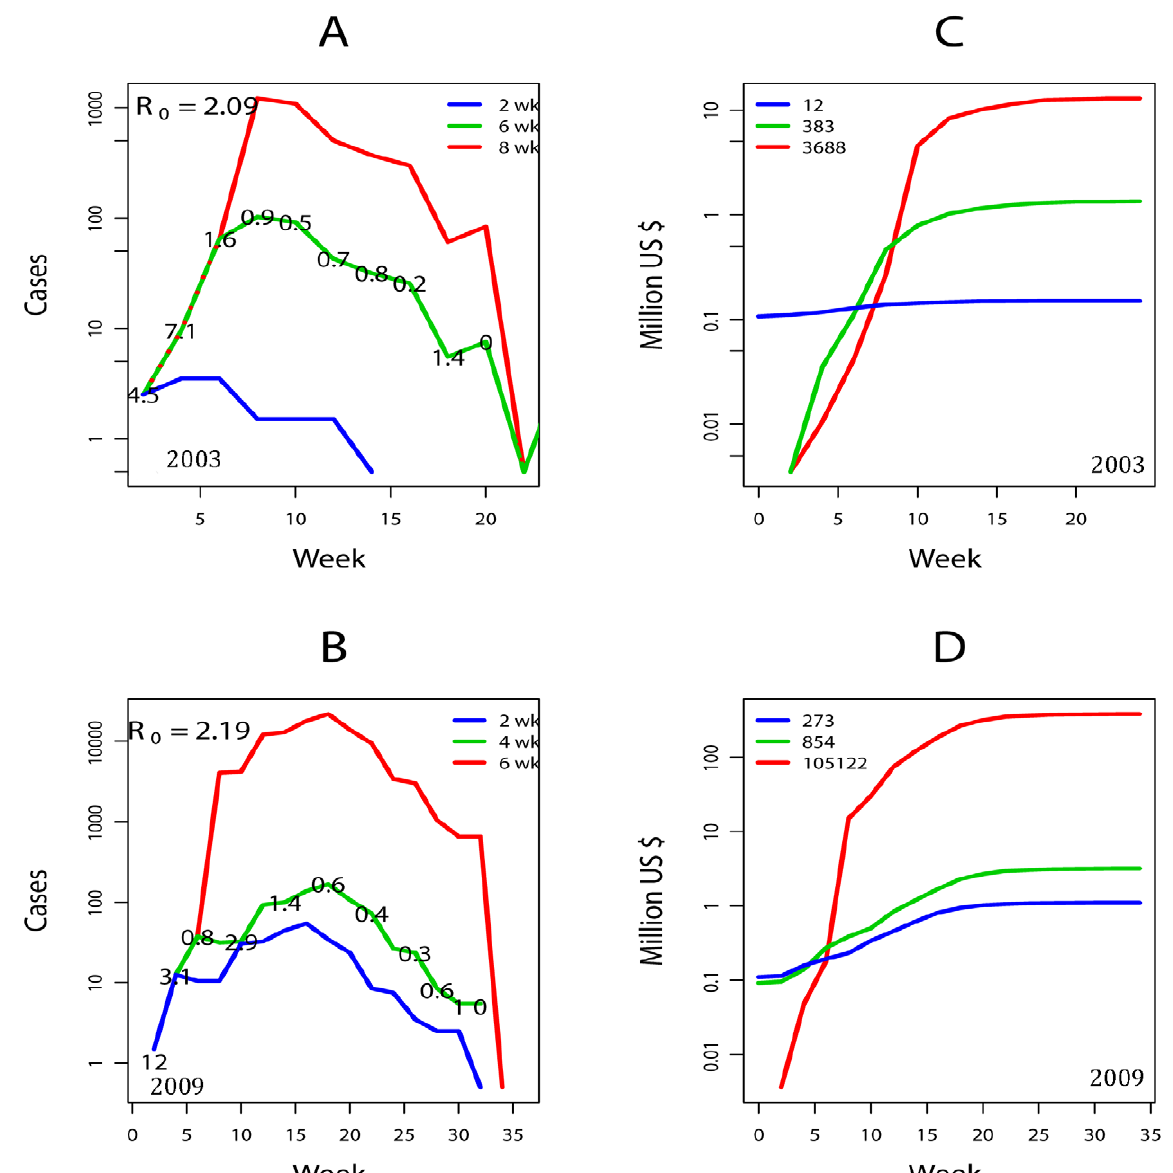
Figure 1. Impacts of hypothetical scenarios of delayed response of vector control to Dengue virus outbreaks. The basic reproduction number, R 0 (the average number of secondary cases after the introduction of an infection) for the 2003 and 2009 dengue fever outbreaks that affected the city of Cairns, Australia, was estimated by fitting an exponential function to the observed weekly epidemic curves before vector control interventions began (6 weeks in 2003 and 4 weeks in 2009). The effective reproduction number, R t (the average number of secondary cases per primary case at time t ) of each outbreak was estimated by accumulating the number of cases in biweekly periods (the average generation time of dengue is , 14 days) and computing the ratio between consecutive two-week periods. The hypothetical epidemic curves for the 2003 ( A ) and 2009 ( B ) outbreaks under different scenarios for response times ( res ) of vector control activities to a dengue introduction ( res =2, 4, 6 and 8 weeks) were computed by estimating the number of cases in the absence of control (between t 0 and res ) using R 0 , and then generating the rest of each epidemic time series by multiplying the number of cases by the estimated post intervention R t in the original series. Blue lines indicate a faster response time than in the actual outbreak, red lines indicate scenarios where the response is delayed in comparison to the actual outbreak, and green lines indicate the actual outbreak. Values on top of the green lines are estimates for R t . Cumulative cost (in 2009 US $ ) of each res scenario were estimated for the 2003 ( C ) and 2009 ( D ) outbreaks. Figure legends refer to each res scenario (A,B) and to the final epidemic size of each scenario (C,D).